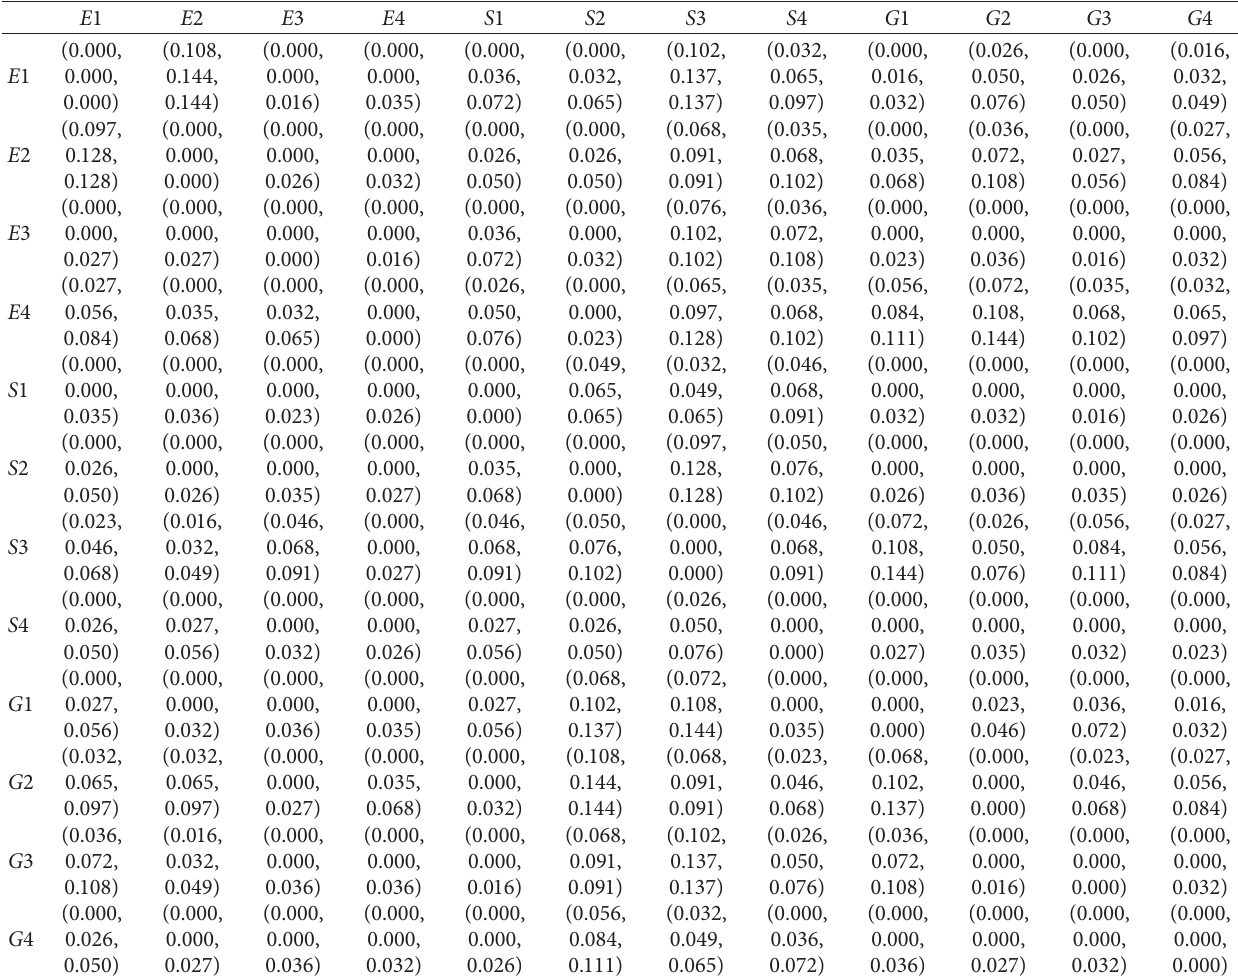
Table 10: Normalized matrix of sustainability criteria in Z-number condition.